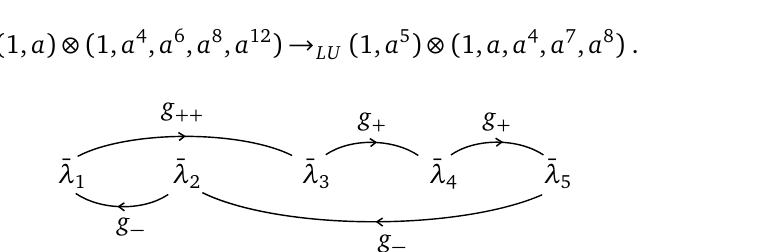
= { 0,1,1, − 1,0 } that leads to a trivial b